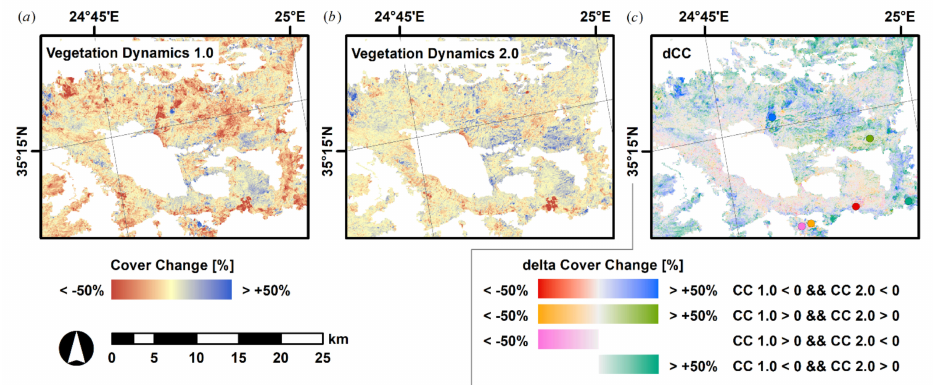
Figure 6. Zoom on Psiloritis area, i.e., study area of [42]. ( a , b ) As in Figure 5. ( c ) Delta cover change ( ∆ CC ), i.e., Figure 6a,b. The colors read as follows: blue to red colors represent a cover loss in both methods, while blue (red) indicates less (more) loss in the Vegetation Dynamics 2.0 methodology; green to orange colors represent a cover gain in both methods, while green (orange) indicates a larger (smaller) gain in the Vegetation Dynamics 2.0 methodology. Pink and cyan represent areas with different change directions, where pink indicates a loss (gain) in Vegetation Dynamics 2.0 (1.0) and cyan indicates a gain (loss) in Vegetation Dynamics 2.0 (1.0). The point signatures in ( c ) refer to the pixels shown in Figure 7. White areas are non-natural areas or above 1500 m a.s.l., which were out of scope of this